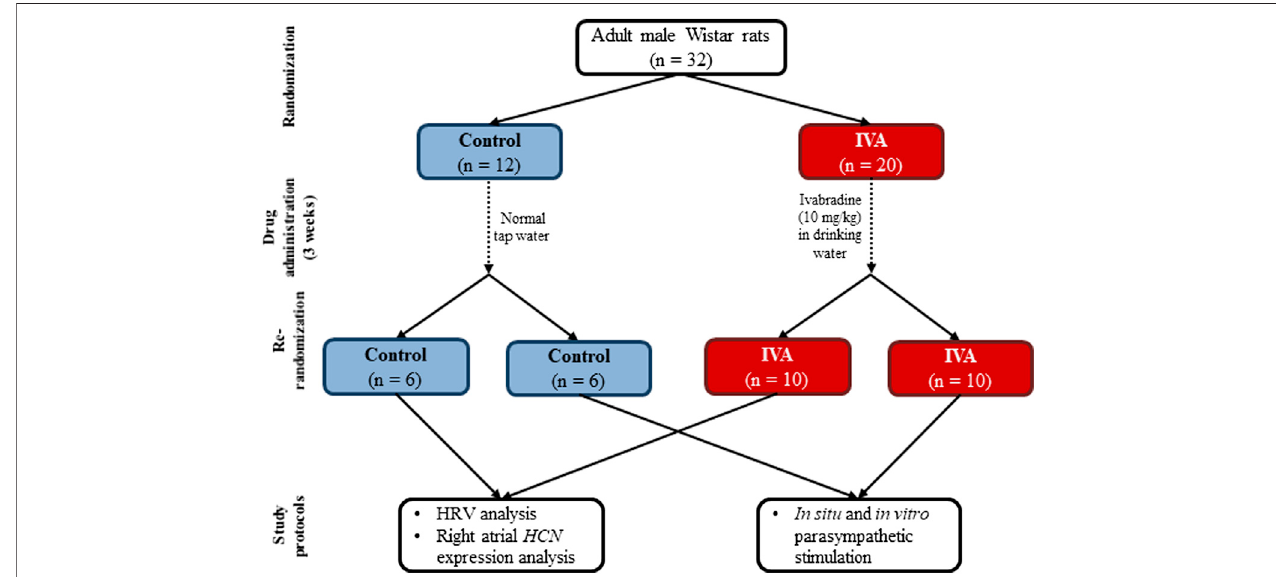
FIGURE 1 | The fl ow chart of the study design for the Control and the ivabradine-treated (IVA) groups. HRV – heart rate variability